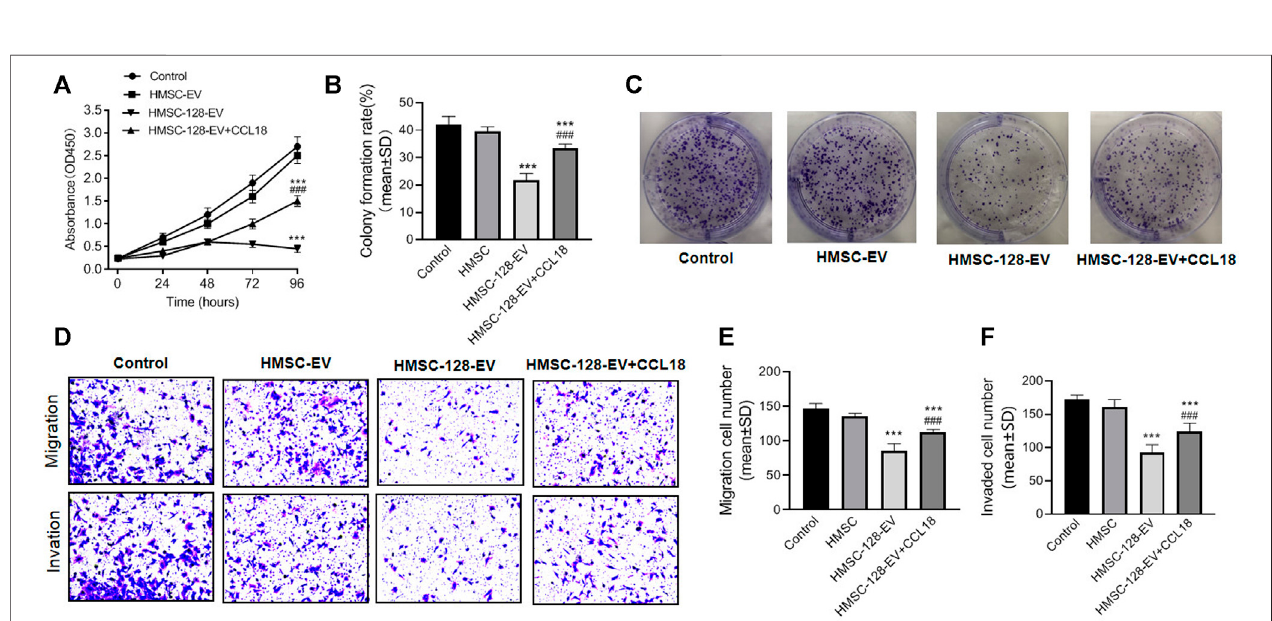
FIGURE5| HMSC-128-EVinhibited BUCT24proliferation,migration, invasion. (A) istheresultofcellviabilityassaysbyCCK8,whichshowedthatHMSC-128-EV could signi fi cantly inhibit the viability ofBUC T24 when co-cultured for 96 h. (B, C) arethe results of clonogenic assay testing cell proliferation, and HMSC-128-EVcould signi fi cantly inhibit the proliferation capacity of BUC T24. (D – F) are the results of Transwell cell migration and invasion assays, and HMSC-128-EV could signi fi cantly inhibit the migration and invasion abilities of BUC T24. *** p < 0.001 vs. Control, ### p < 0.001 vs. HMSC-128-EV.